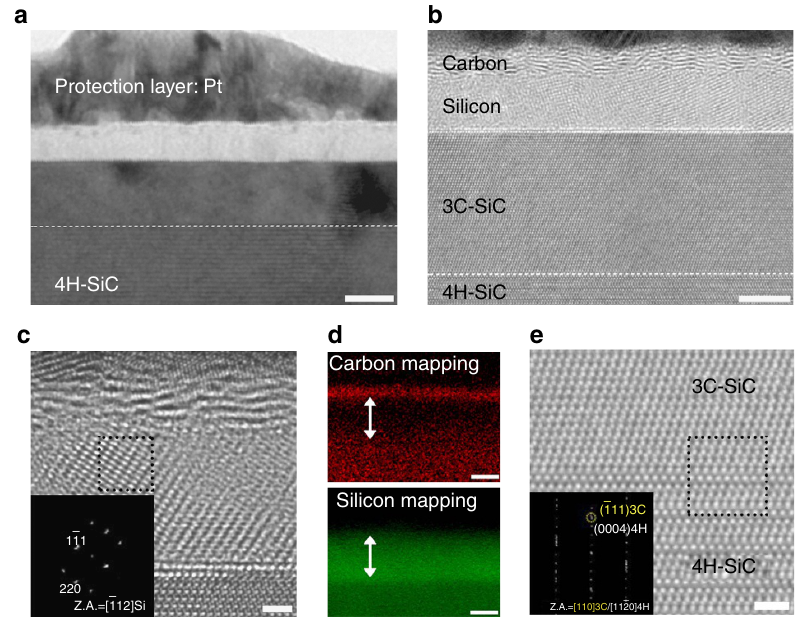
Figure 1 | Phase separation of 4H-SiC by XeCl excimer laser irradiation. ( a ) Bright-field TEM image of 4H-SiC surface with single-pulse irradiation. The dotted line indicates the boundary between newly formed layers and the 4H-SiC substrate. Scale bar, 10nm. ( b ) HRTEM image of a phase separated area and a 3C-SiC layer on top of the 4H-SiC in a . Scale bar, 5nm. ( c ) Magnified HRTEM image of the poly-Si layer. Scale bar, 1nm. Inset shows a fast Fourier transform pattern of the black-dotted area. ( d ) EFTEM mapping of C and Si elements of the phase-separated layer. Double-sided arrows indicate the position of the poly-Si layer. Scale bars, 5nm. ( e ) Magnified HRTEM image of the boundary area between 3C-SiC and 4H-SiC. Inset is the FFTpattern of the interface between 3C-SiC and 4H-SiC in the black-dotted area. Scale bar, 1nm.